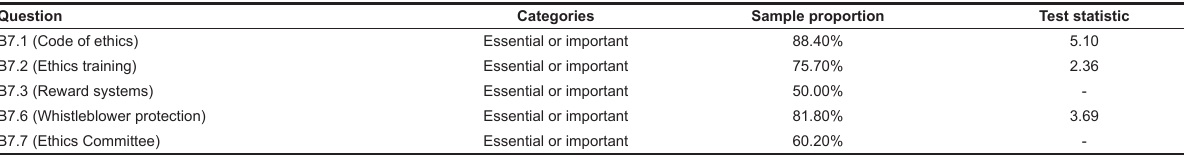
TABLE 7 Relative importance of ethical intervention